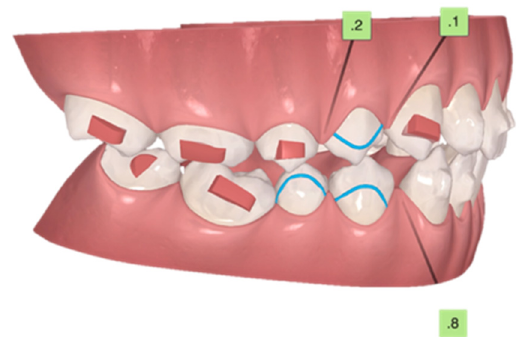
Figure 10. Third AA stage.